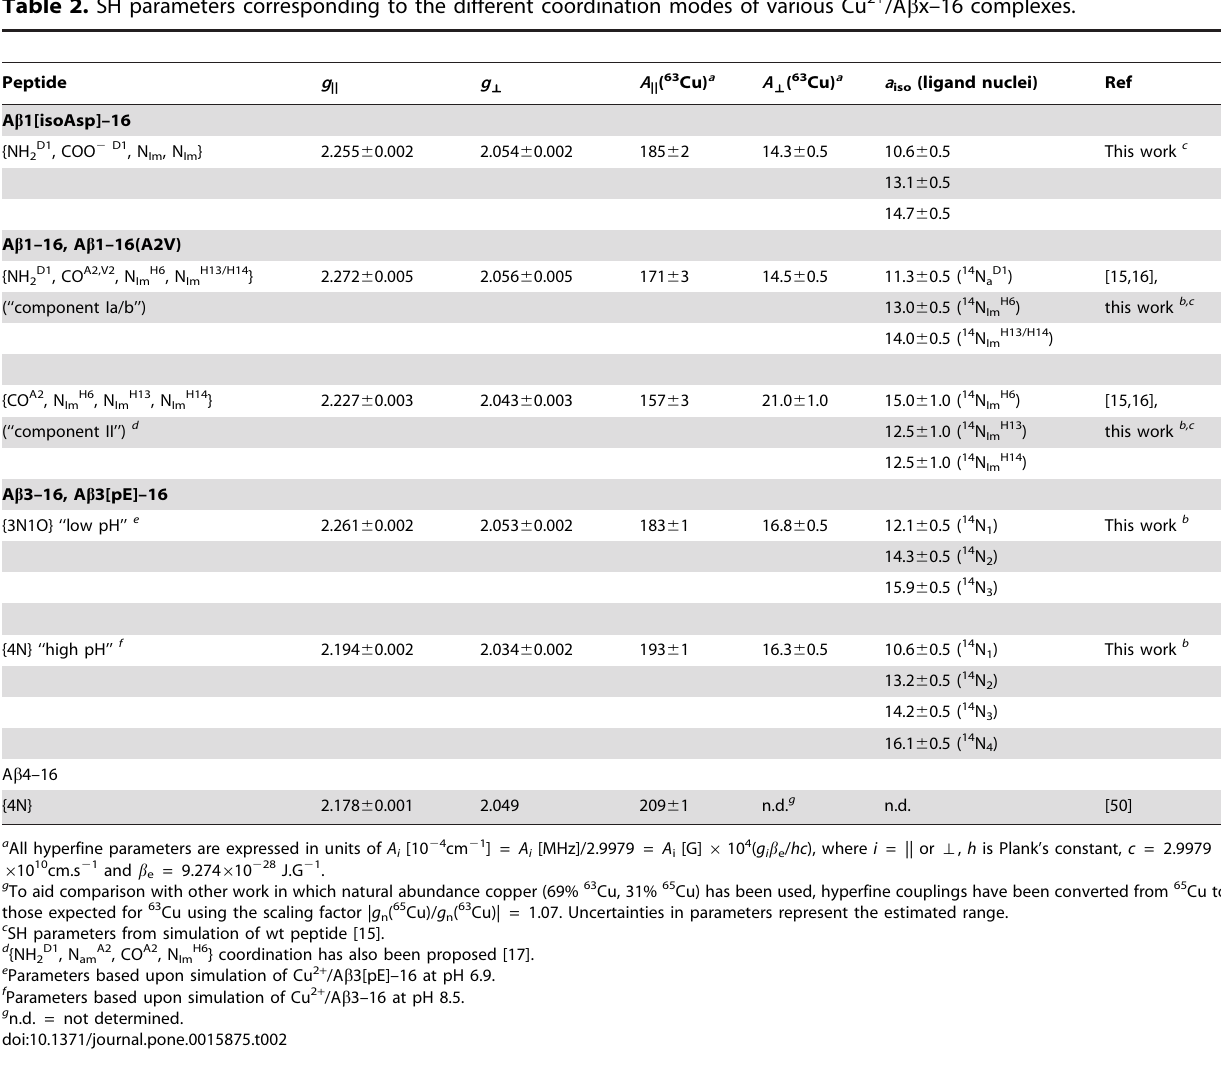
Table 2. SH parameters corresponding to the different coordination modes of various Cu 2 + /A b x–16 complexes.